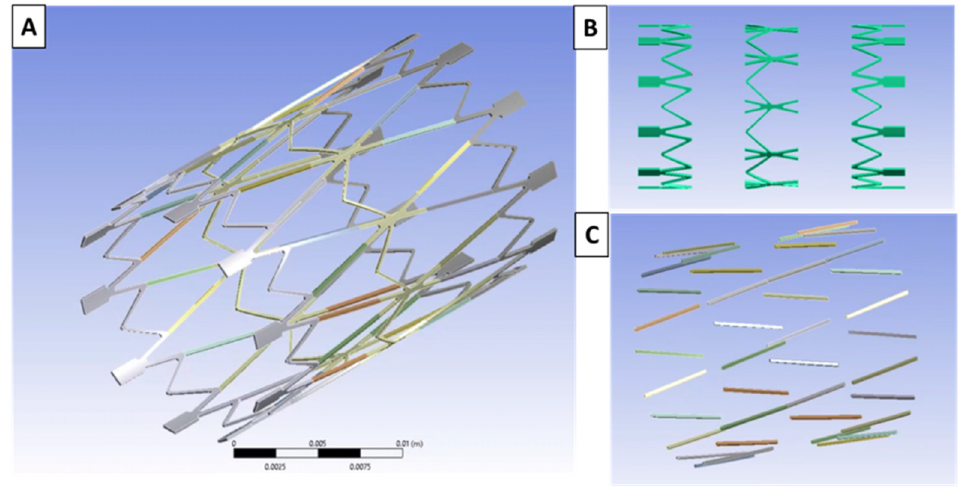
Figure 4. The 3D modeling of the pediatric heart valve: ( A ) valve’s struts linked with connections, ( B ) nitinol connections, and ( C ) iron-based struts.